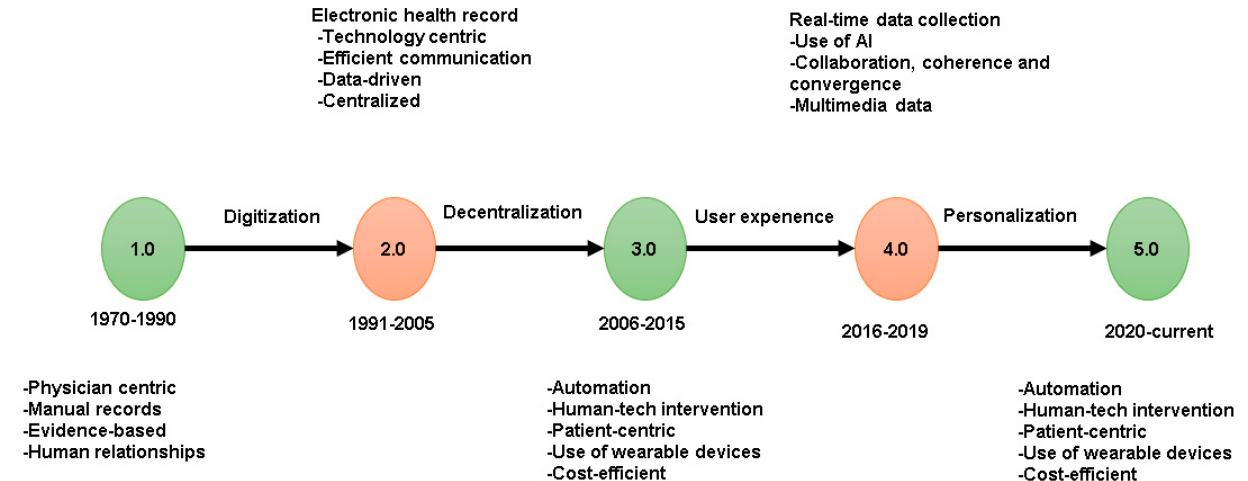
Figure 2. Historical perspective on healthcare 1.0 to 5.0 .